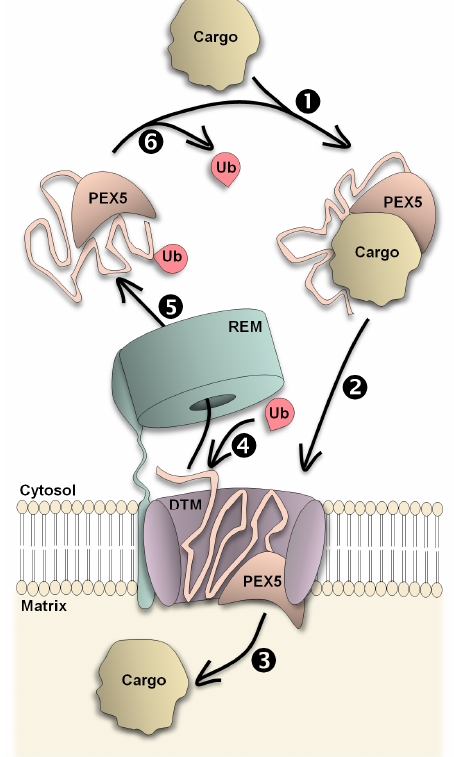
Figure 1. Figure 1. Import of peroxisomal matrix proteins. A newly synthesized matrix protein (“Cargo”)